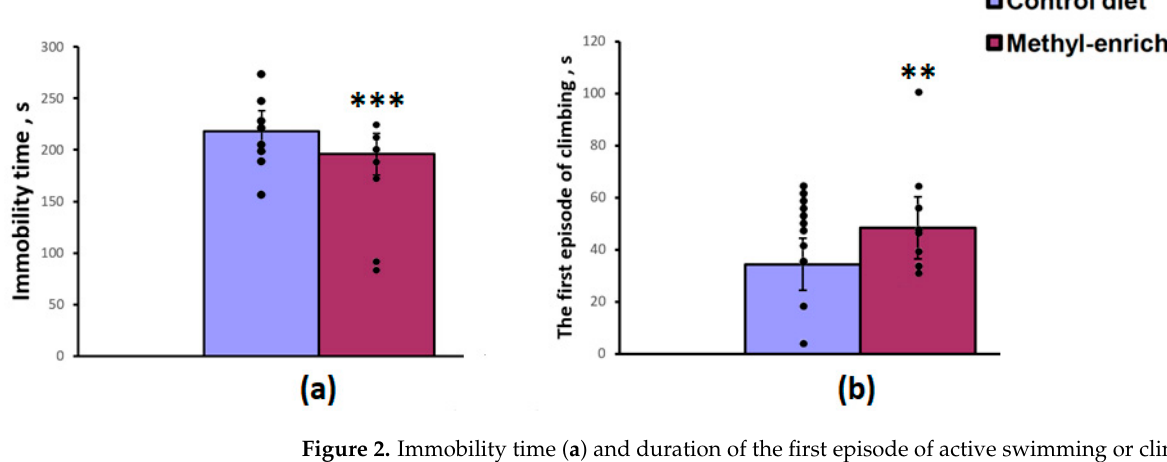
Figure 2. Immobility time ( a ) and duration of the first episode of active swimming or climbing ( b ) in the forced swimming test in adult offspring of WAG/Rij rats born to mothers fed a methyl-enriched ( n = 8) or control diet ( n = 13). Data are the mean ± S.E.M. The individual data points are displayed in bar graphs to show within-group variability. ***— p < 0.001, **— p < 0.01 compared with the corresponding values in the control group.